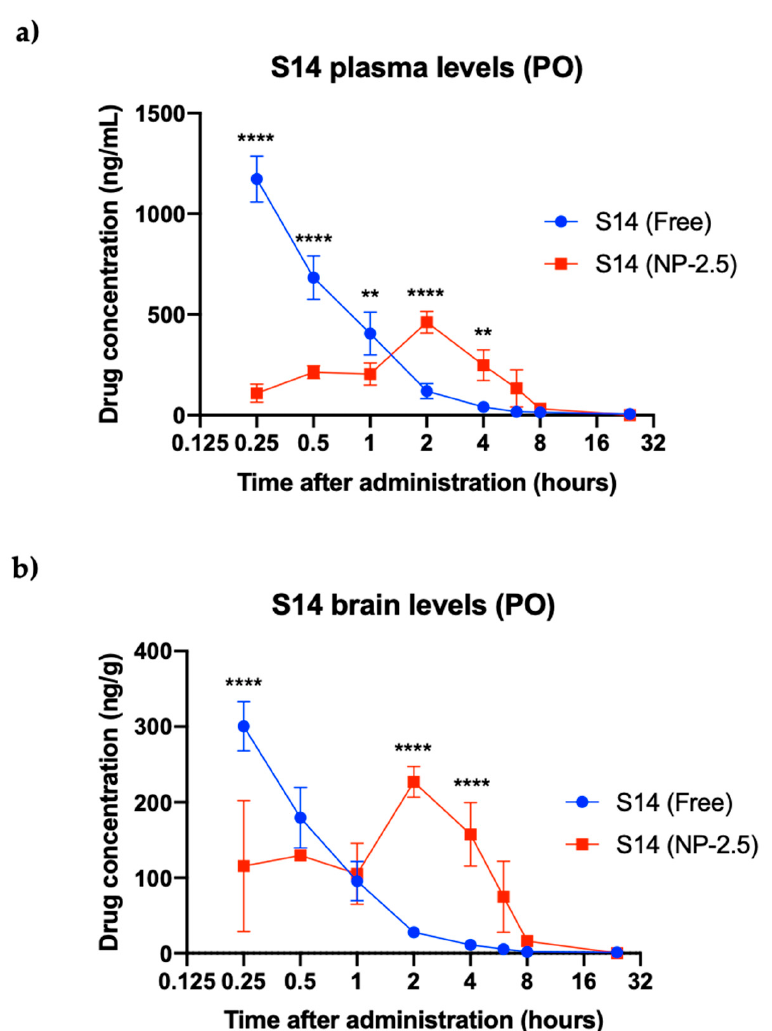
Figure 8. In vivo release experiments for free S14 vs. S14-loaded PLGA nanoparticles. S14 plasma levels ( a ) and brain levels ( b ) after oral administration (10 mg/kg). (** p < 0.005, **** p < 0.0001 significantly different from free